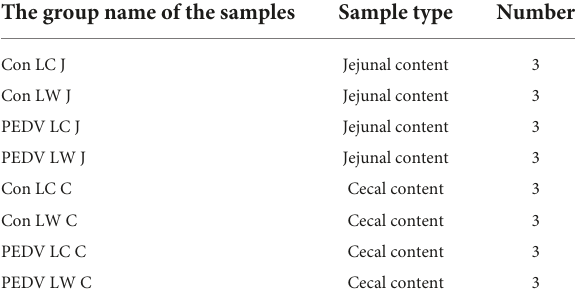
TABLE 2 The information of samples collected for microbiota analysis.